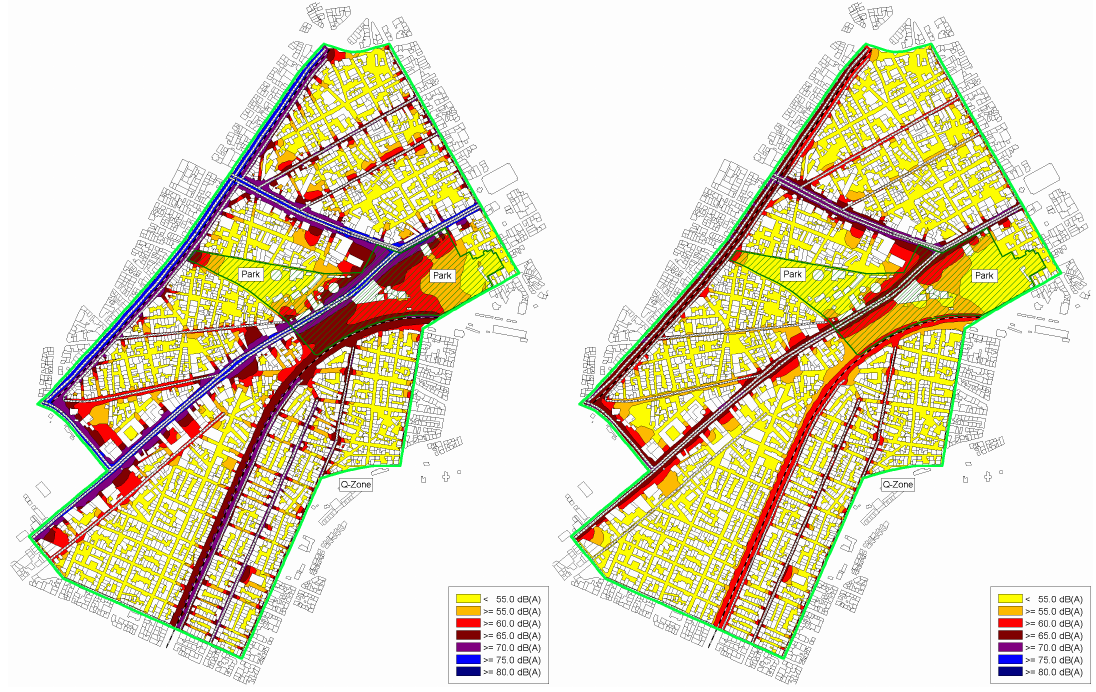
Figure 8: Scenario S03 - L